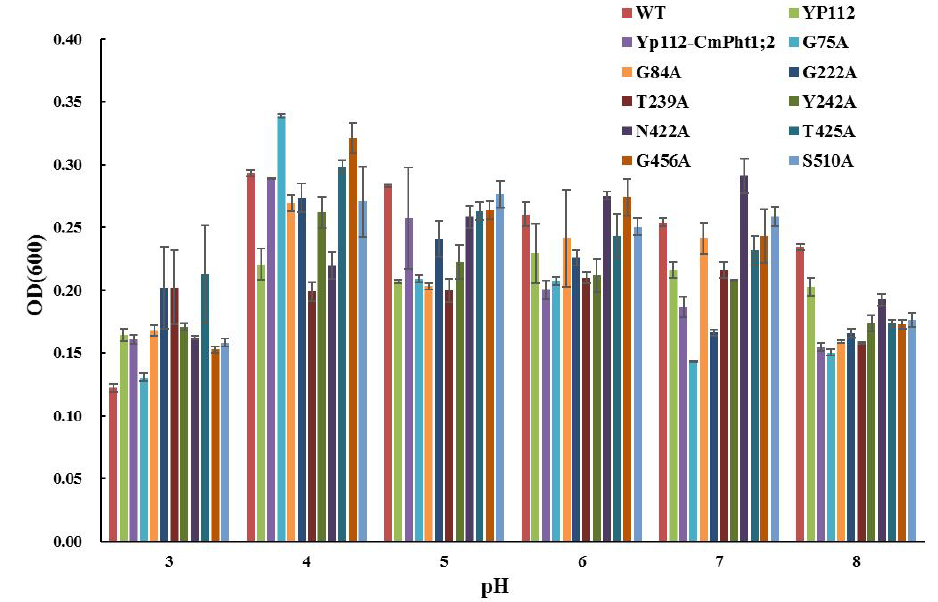
Figure 4. MB192 with CmPT2 and Cmphts expression growing under different pH condition.